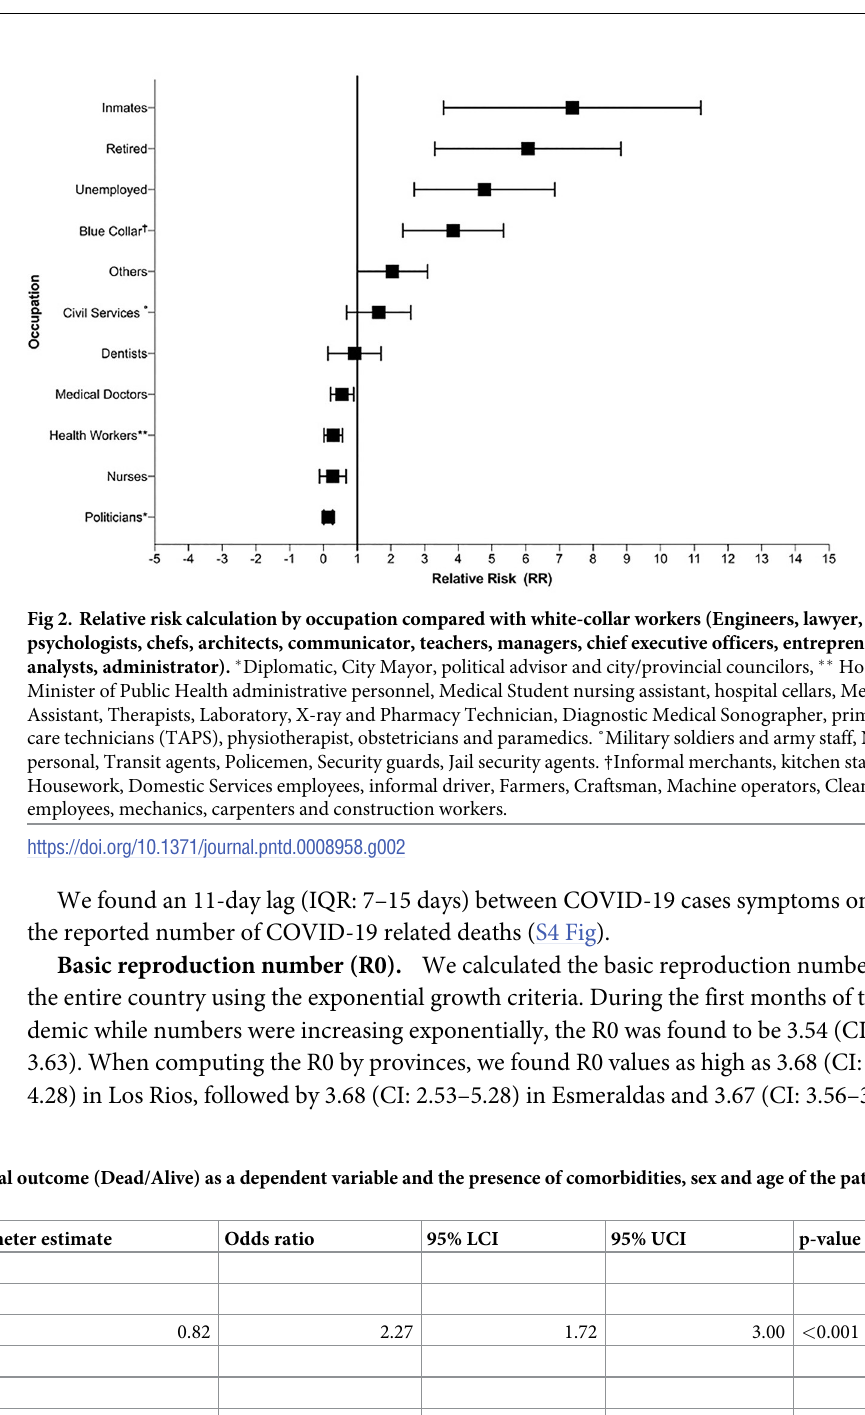
Table 4. Adjusted logistic regression using final outcome (Dead/Alive) as a dependent variable and the presence of comorbidities, sex and age of the patients as a covariate. Model risk for COVID-19 Parameter estimate Odds